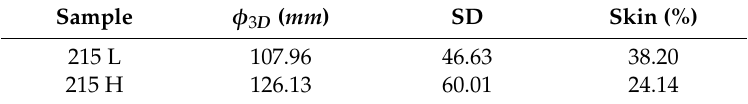
Table 2. Cell size, standard deviation and skin thickness of 215 L and 215 H foamed samples.